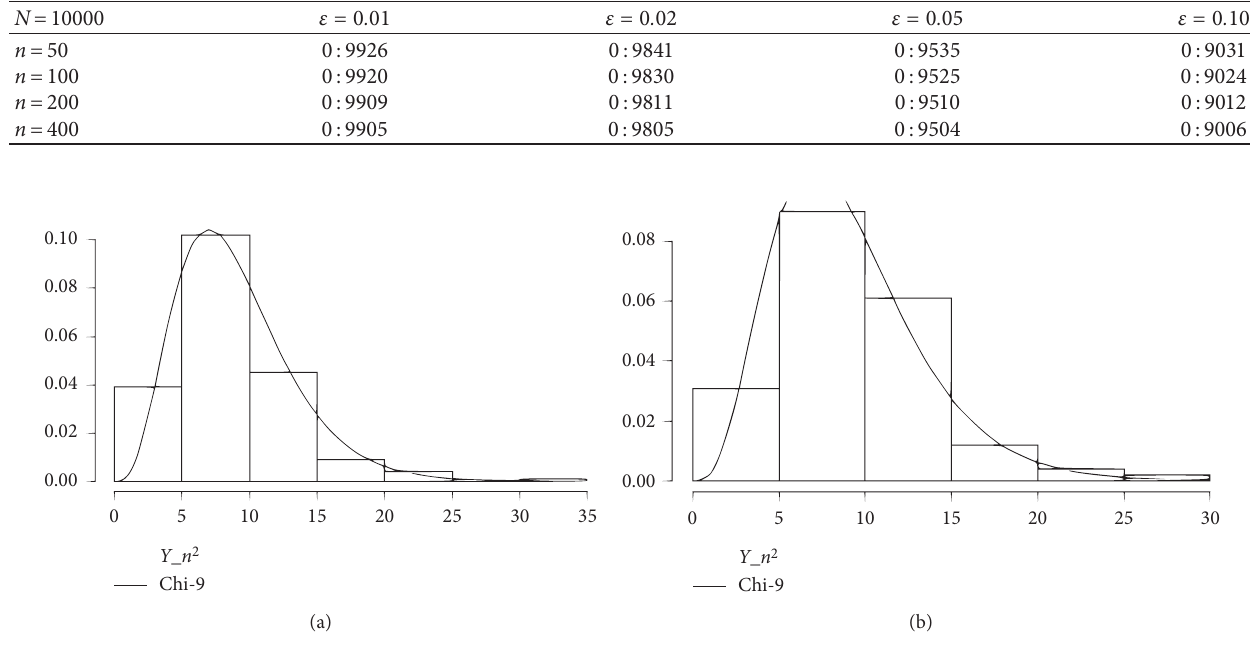
Figure 11: 􏽢 α � 1 . 5, 􏽢 c � 1 . 5, and 􏽢 a � 0 . 9 (a) and 􏽢 α � 1 . 5, 􏽢 c � 0 . 5, and 􏽢 a � 1 . 2 (b).